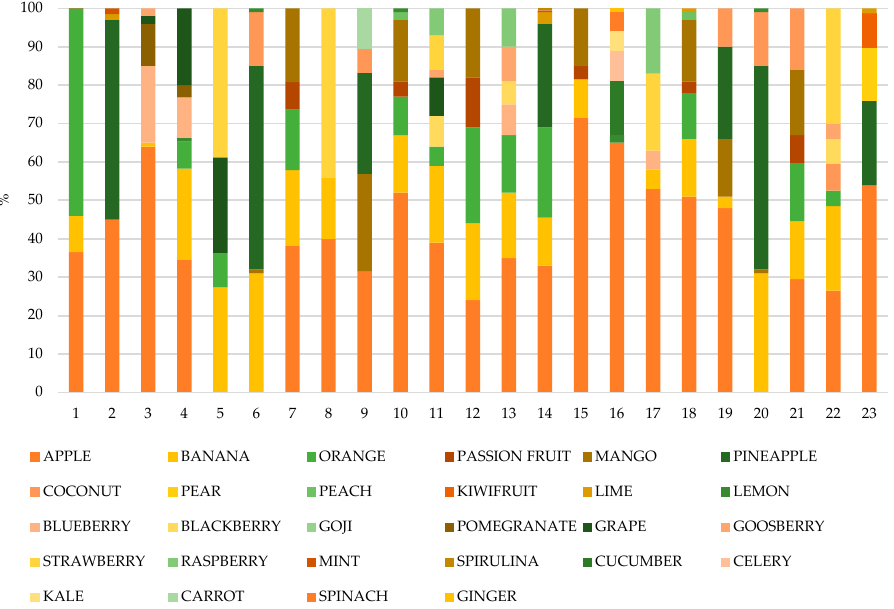
Figure 1. Ingredients of the evaluated smoothies expressed as percentage.